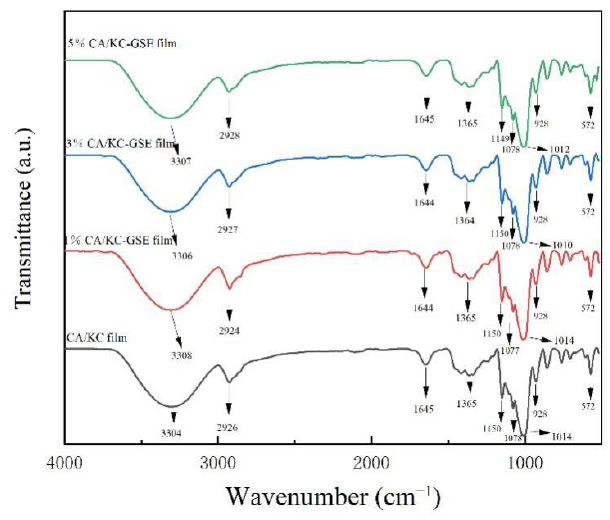
Figure 2. FT- IR spectra of CS/к C, 1% CS/к C - GSE, 3% CS/к C - GSE, and 5% CS/к C -GSE films. Figure 2. FT-IR spectra of CS/ κ C, 1% CS/ κ C-GSE, 3% CS/ κ C-GSE, and 5% CS/ κ C-GSE